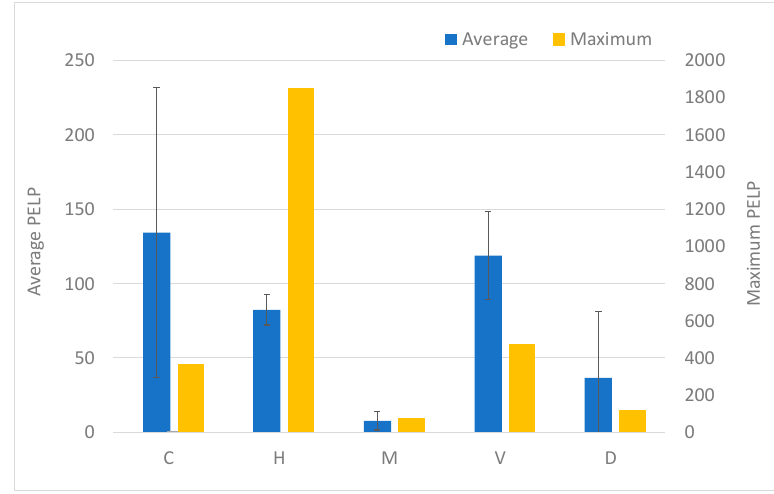
Figure 5. Difference of PELP by residential type. Figure 5. Di ff erence of PELP by residential